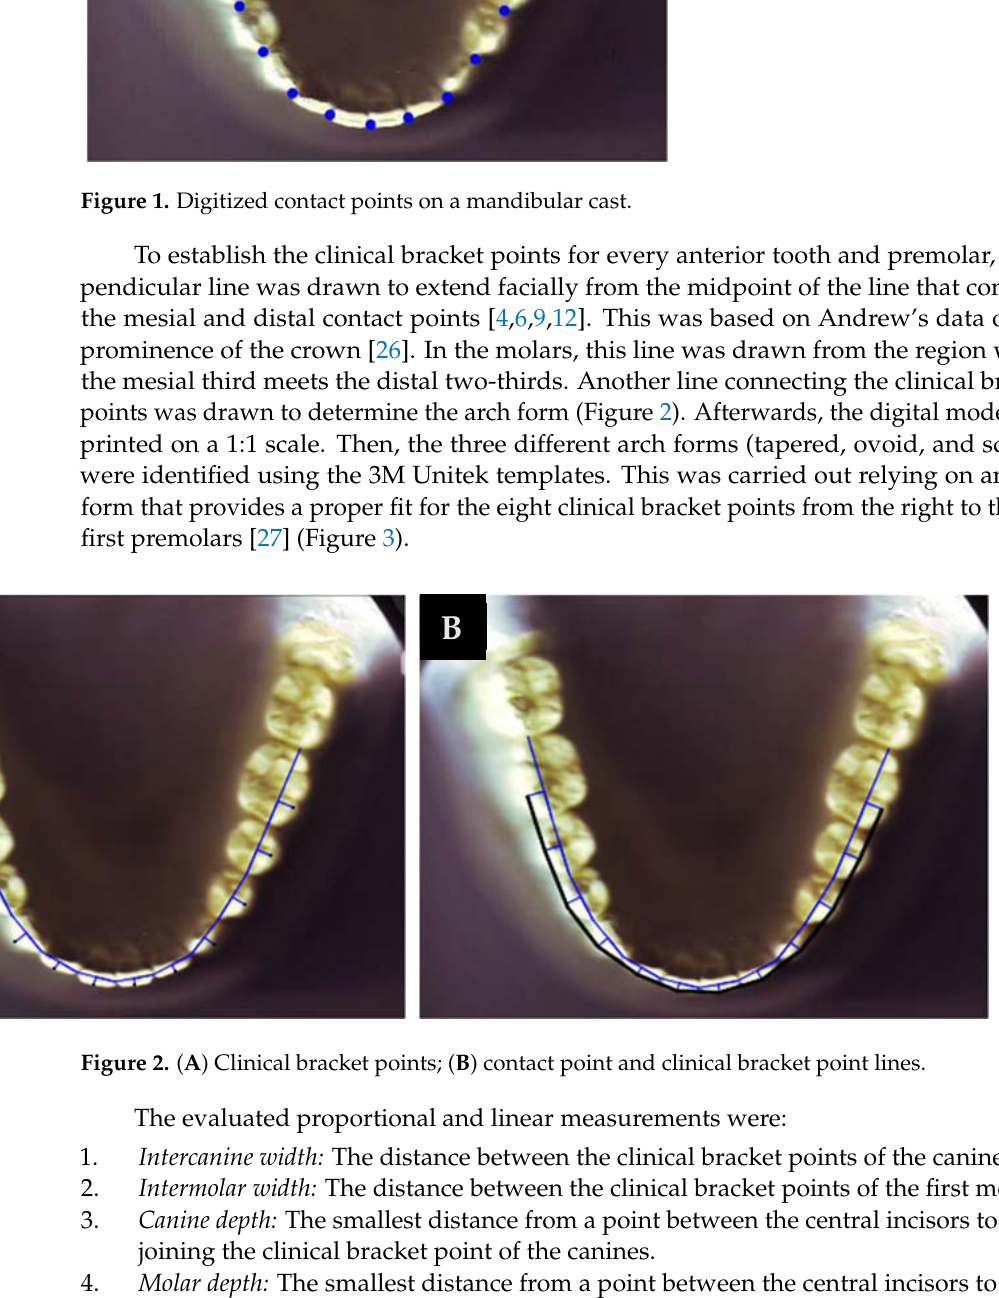
Figure 2. ( A ) Clinical bracket points; ( B ) contact point and clinical bracket point lines.